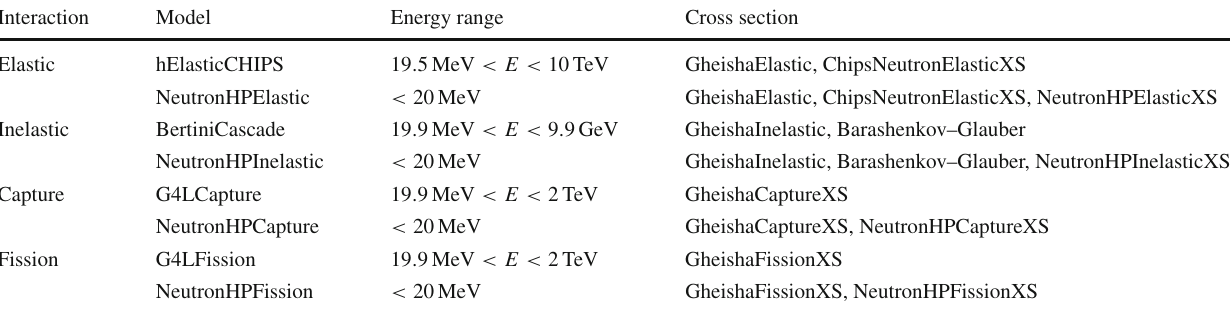
Table 3 Geant4 MC models for neutron propagation and absorption